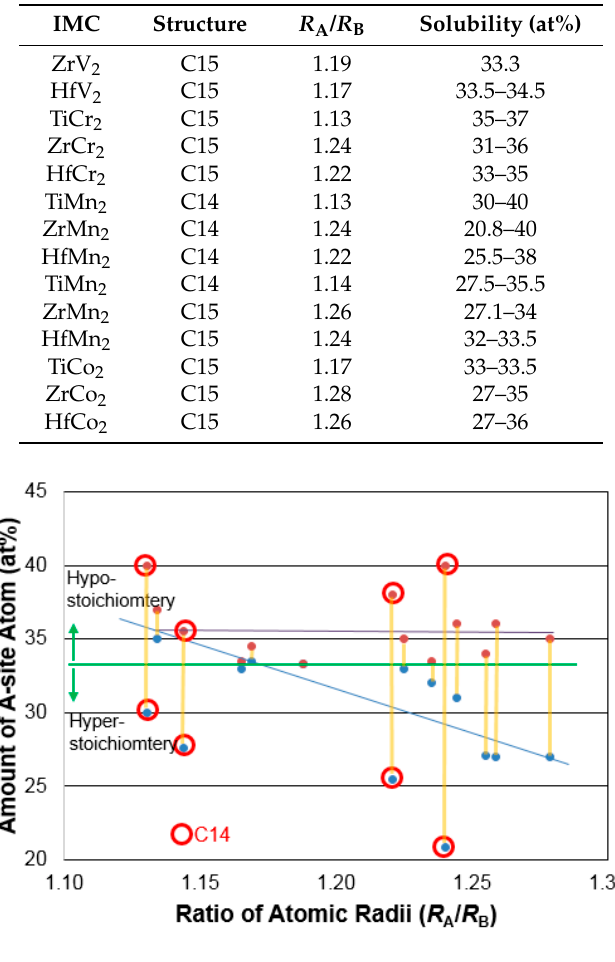
Figure 15. Plot of solubility (composition range) vs. ratio of atomic radii between A-site and B-site atoms from Ti, Zr, Hf-based Laves phase intermetallic compounds (IMCs). Red and blue dots are the upper and lower bounds of the AB 2 soluble range (yellow vertical line) in the composition. Data points in red circles are from C14 phases and other unmarked data points are from C15 phases. Table 9. Solubility (range of A-site atom concentration in at %) of Laves phase IMCs (radius from [148] and solubility from [257]).